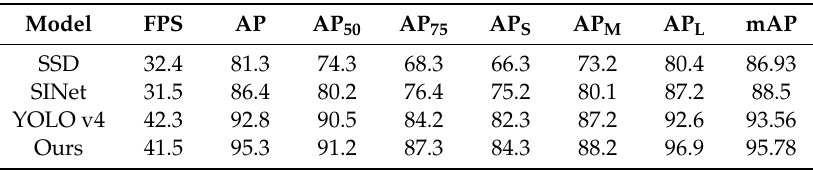
Table 1. Comparison of test results of di ff erent